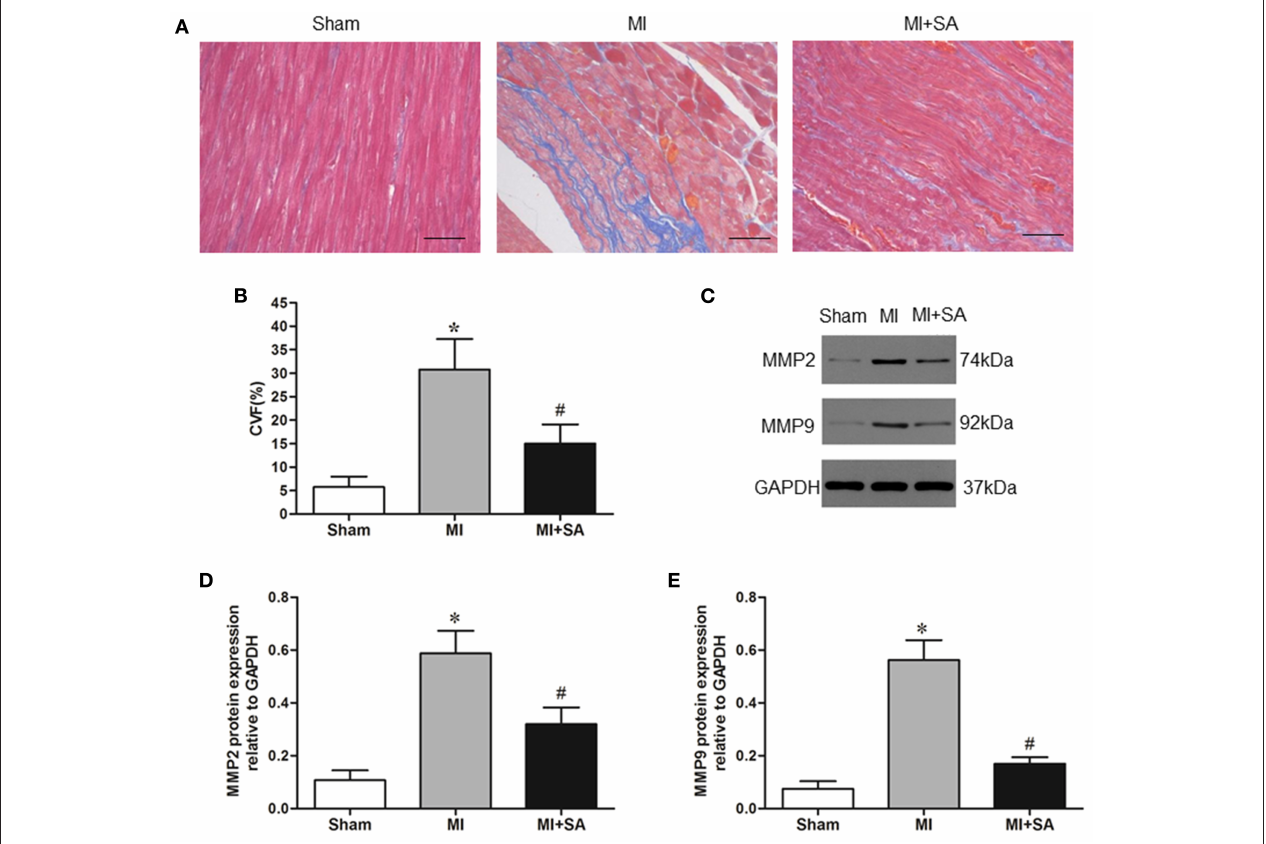
FIGURE 6 | The effect of SA on myocardial fibrosis at 4 weeks after MI. (A) Interstitial fibrosis (blue) detected by Masson staining in the sham group, MI group, and MI + SA group. Scale bar, 50 µ m. (B) Comparison of collagen volume fraction. (C) Expression of MMP9 and MMP2 proteins in the three groups. (D,E) Quantitative assessment of MMP9 and MMP2 protein levels. *Compared with the sham group, P < 0.05, # Compared with the MI group, P < 0.05, n = 8 in each